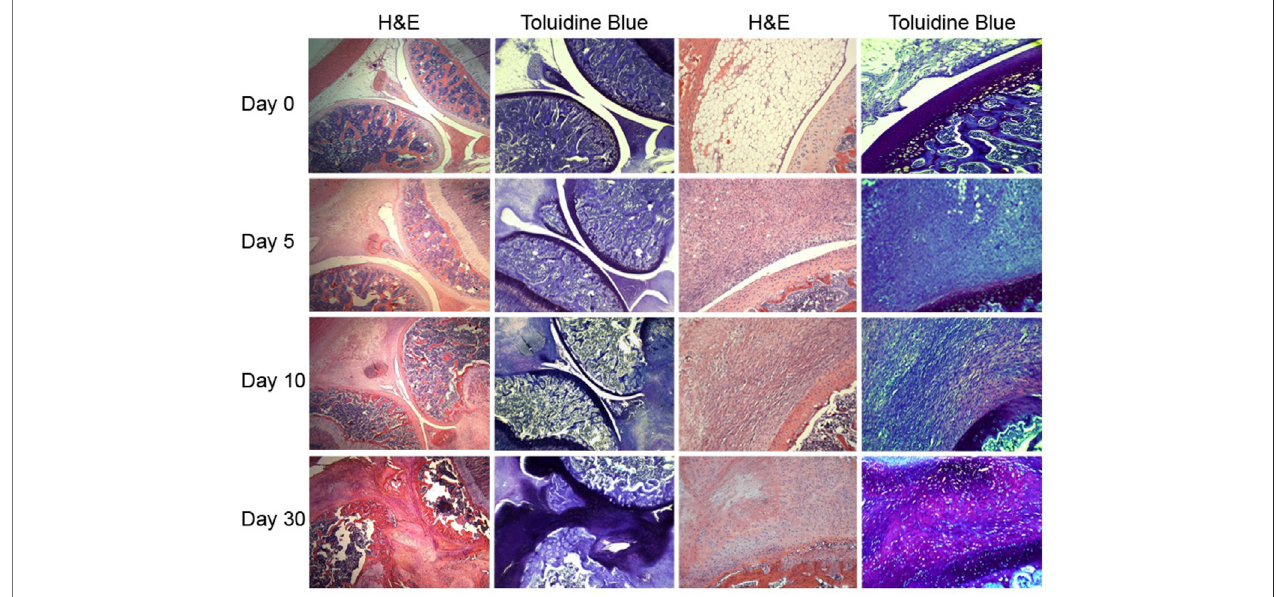
FIGURE 6 | Severe synovial fi brosis and chondrometaplasia induced by intra-articular gene delivery of TGF- β 1. The sti fl e joints (hind knees) of nude rats were injected bilaterally with 2 × 10 9 viral particles of Ad.TGF- β 1. Groups of animals were killed at days 0, 5, 10, and 30, and the joints were harvested and processed for histology. Adjacent sections were stained with H&E or toluidine blue as indicated. The images in left two columns are at ×2.5 magni fi cation, while those in the right two columns are at ×20. At Day 5, expansion of spindled fi broblasts from the synovial lining and joint capsule produced a dense fi brotic mass that fully occluded the underlying adipose layer. By Day 10, the fi brotic tissue had expanded to displace all the soft tissue structures and began to fuse with articular cartilage, in which the developmentofrounded chondrocytic cells canbeseen.By Day30,thebulkofthe fi broticexpansehad differentiated intoacartilaginous phenotype asindicatedbythe cellularmorphologyandmetachromatictoluidinebluestaining.Insomeareasthenormalarticularcartilagewasreplacedbymetaplastic fi brocartilaginoustissuethatalso permeated the subchondral and periarticular bone. Figure copied with permission from (Watson et al.,